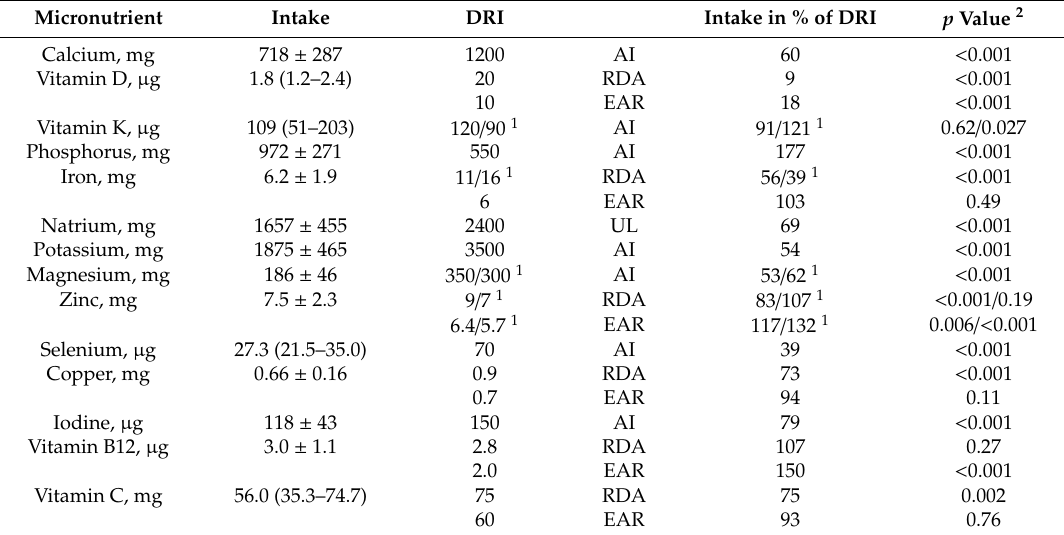
Table 3. Daily micronutrient intake of 39 older hip fracture patients compared to the Dietary Reference Intakes from the Health Council of the Netherlands [41] and American Institute of Medicine (vitamin K)